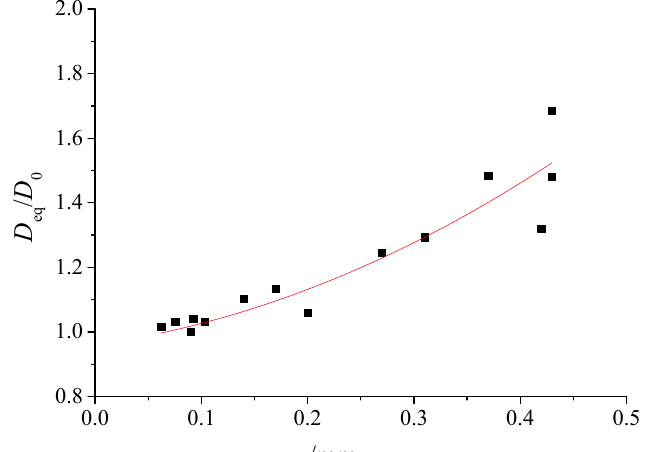
Figure 11. The variation of the ratio D eq /D 0 versus the crack width obtained from tests.